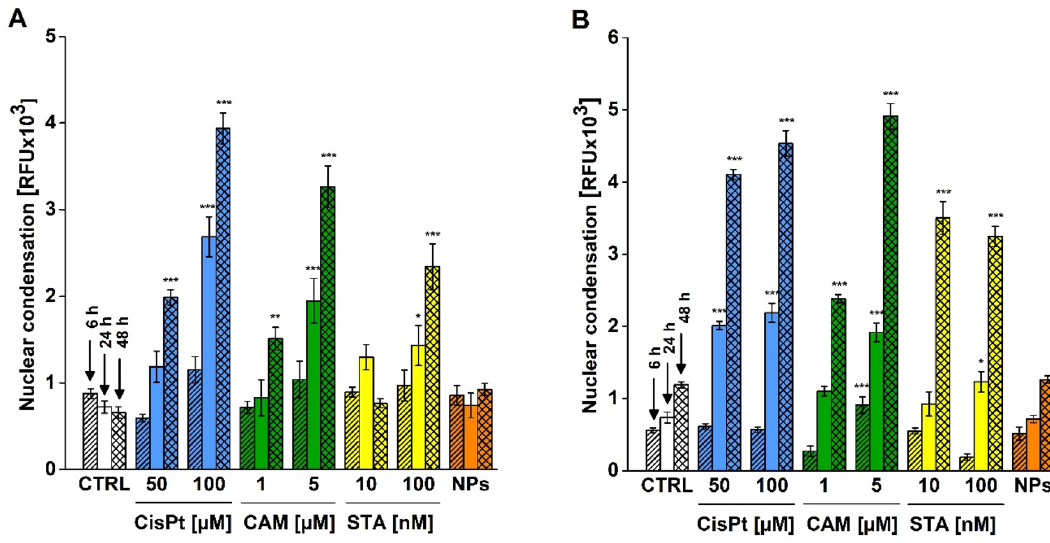
Figure 3. Detection of nuclear condensation and fragmentation using the H33258 spectrofluorometric assay. HepG2 ( A ) and HK-2 ( B ) cells were treated with cisplatin (CisPt, 50; 100 µM, blue columns), camptothecin (CAM, 1; 5 µM, green columns), staurosporine (STA, 10; 100 nM, yellow columns) for 6, 24 and 48 h. Control (CTRL) represents untreated cells. The cells treated with TiO 2 P25 nanoparticles (NPs, 10 µg/mL, orange columns) were used as a negative control. After treatment, the cells were incubated with H33258 (2 µg/mL) for 5 min and intensity fluorescence (EX/EM = 352/461 nm) was measured. Then, the background fluorescence